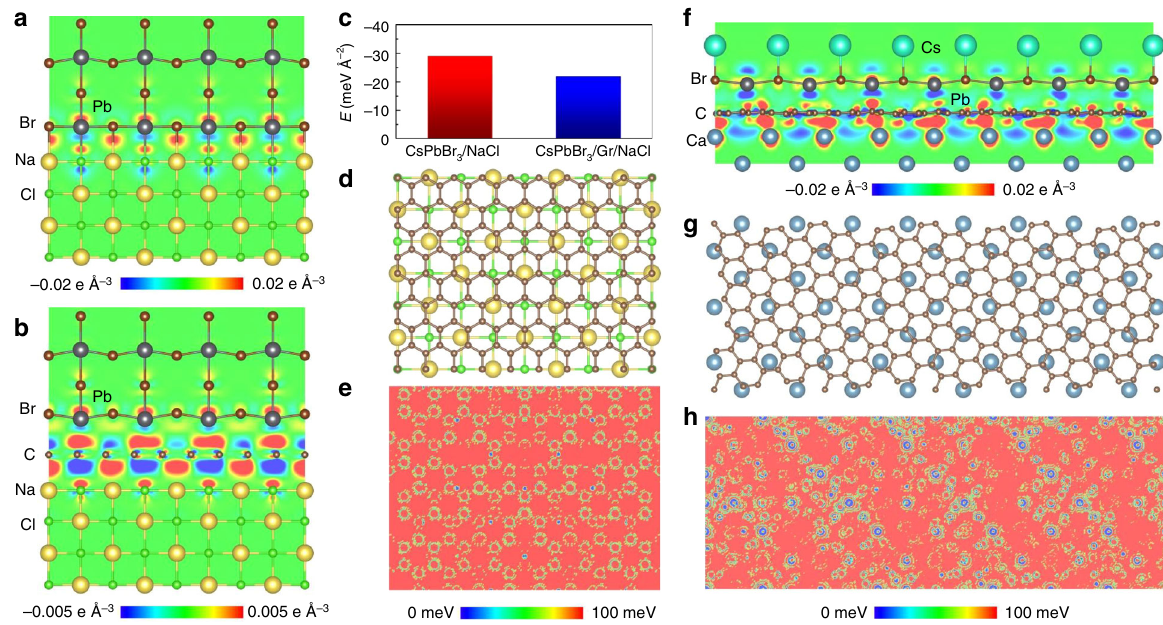
Fig. 2 Ionic and remote atomic interactions between polar substrates and CsPbBr 3 . a , b Charge transfer distributions between CsPbBr 3 (001) and NaCl (001) ( a ), and between CsPbBr 3 (001) and NaCl(001) with graphene intercalation ( b ). c Interfacial interactions between CsPbBr 3 (001) and NaCl(001), between CsPbBr 3 (001) and monolayer graphene buffered NaCl(001). d Atomic stacking between NaCl(001) top layer and buffered monolayer graphene. e Potential fl uctuation at the epitaxial surface from NaCl(001) through monolayer graphene, where blue pattern is consistent with atomic stacking of NaCl (001) in ( d ). f Charge transfer distribution between CsPbBr 3 (011) and CaF 2 (001) with graphene intercalation. g Atomic stacking between CaF 2 (001) top layer and coated monolayer graphene. h Potential fl uctuation at the epitaxial surface from CaF 2 (001) through monolayer graphene, where blue pattern is consistent with center site of four Ca atoms in ( g